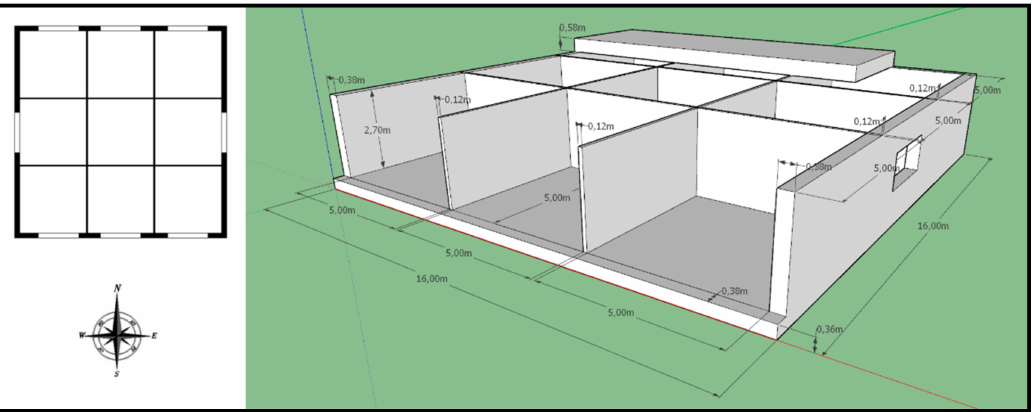
Figure 2. Case study representation.